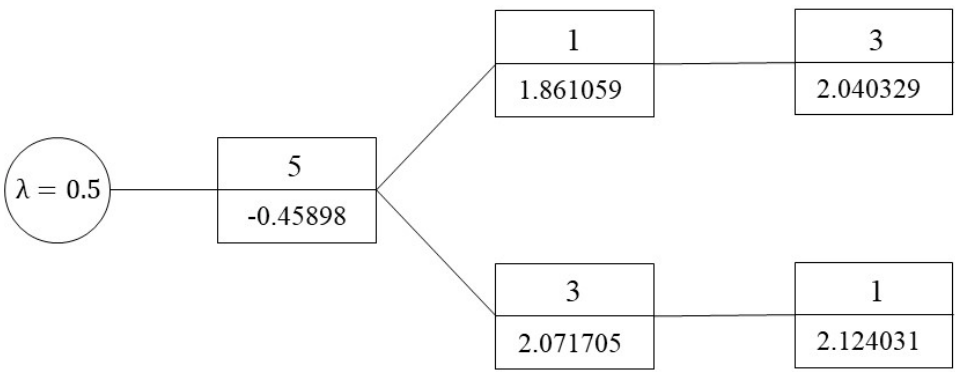
Figure 8. The failure tree and corresponding reliability indices when λ = 0.5.